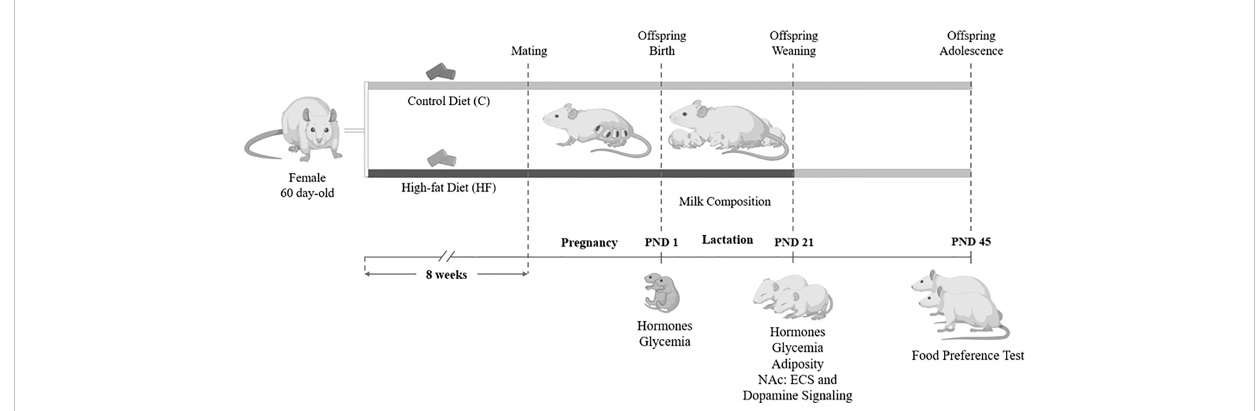
FIGURE 1 Experimental model of maternal high-fat diet and study design. Female Wistar rats (60 day-old) were divided into control group (C, control diet) or High-fat group (HF, high-fat diet). Dams received C or HF diet for 8 weeks prior mating and throughout gestation (21 days) and lactation (21 days). At birth (postnatal day 1, PND 1), male and female pups underwent euthanasia for hormone and glycemia measurement. During lactation, milk samples were collected for endocannabinoid and fatty acid quanti fi cation. At weaning (PND 21), a subset of male and female offspring was killed for hormone, glycemia and adiposity evaluation, and analysis of the endocannabinoid system (ECS) and dopamine signaling in the Nucleus Accumbens (NAc). In the adolescence (PND 45), another subset of the offspring was submitted to a food preference